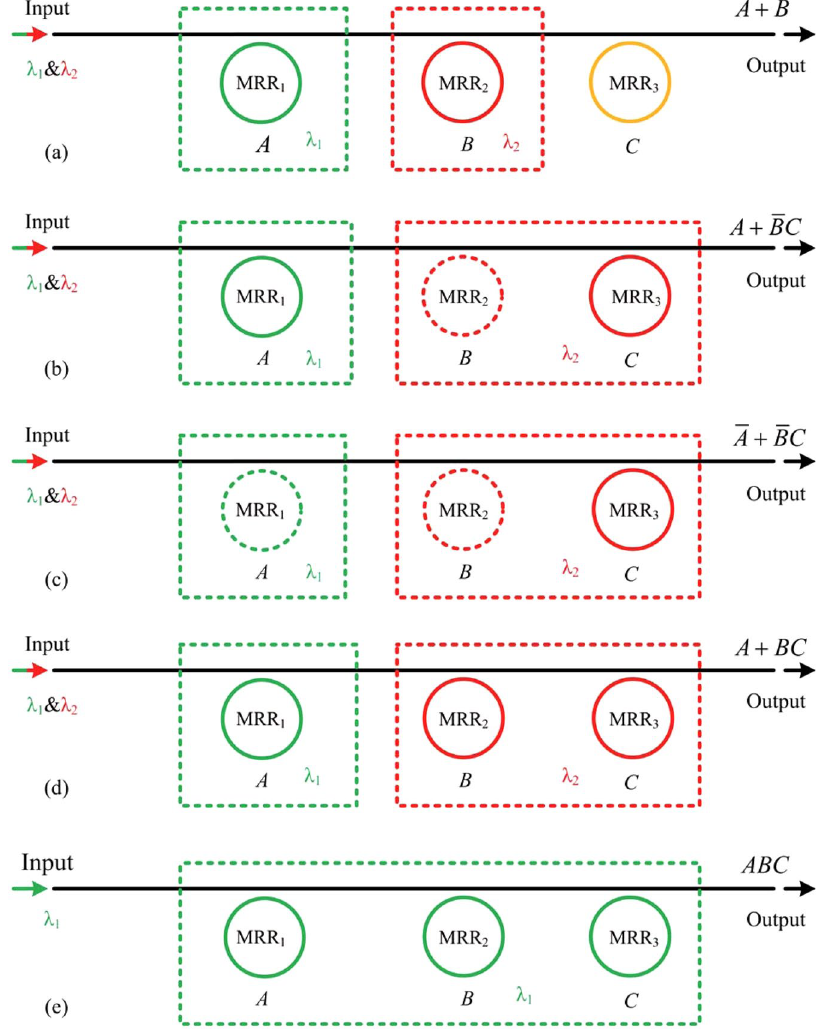
Figure 6. Logic circuit diagrams of the device for different three-input logic operations (the solid line ring denotes MRR works in the block / pass mode, the dot line ring denotes MRR works in the pass / block mode, MRRs with the same color work at the same working